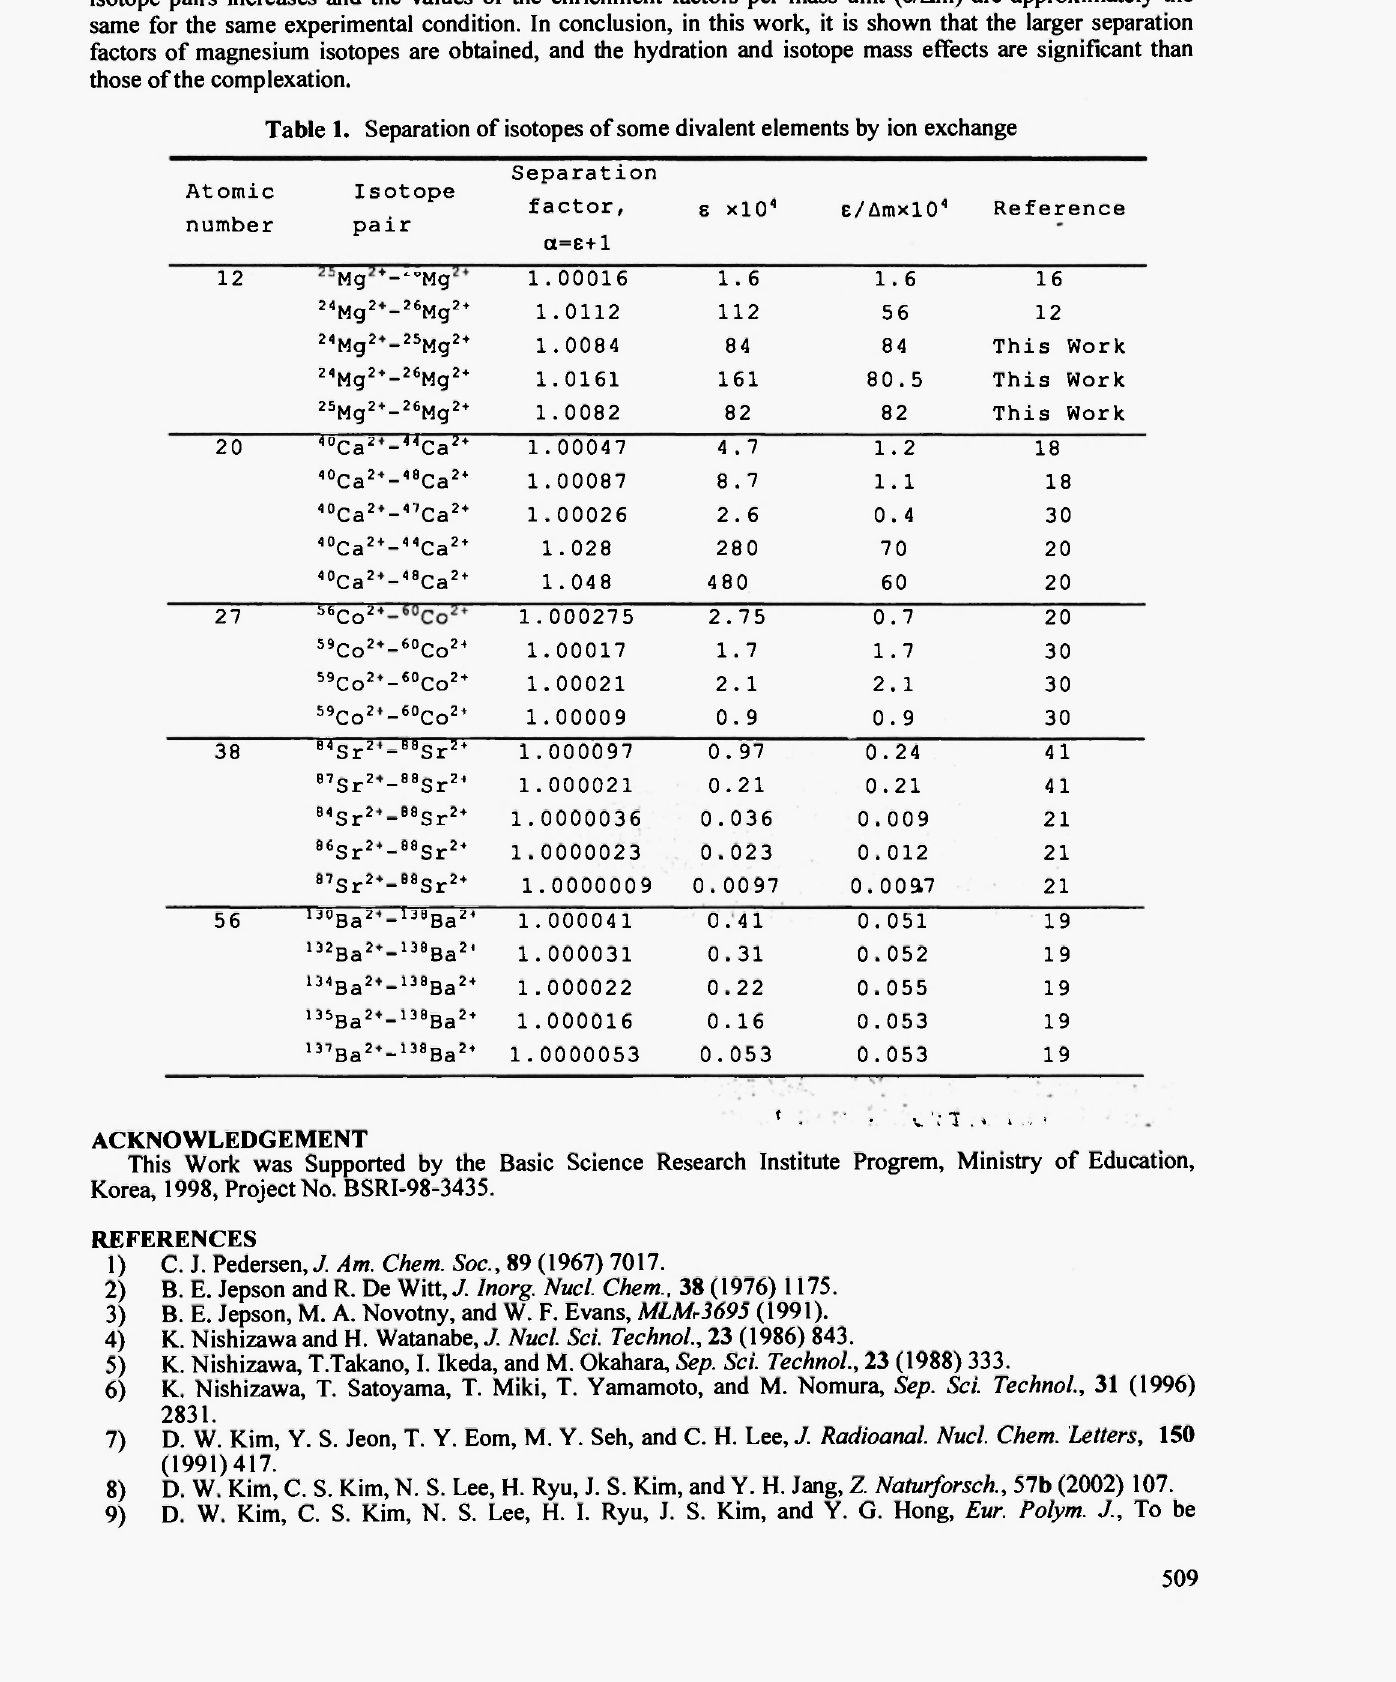
Table 1. Separation of isotopes of some divalent elements by ion